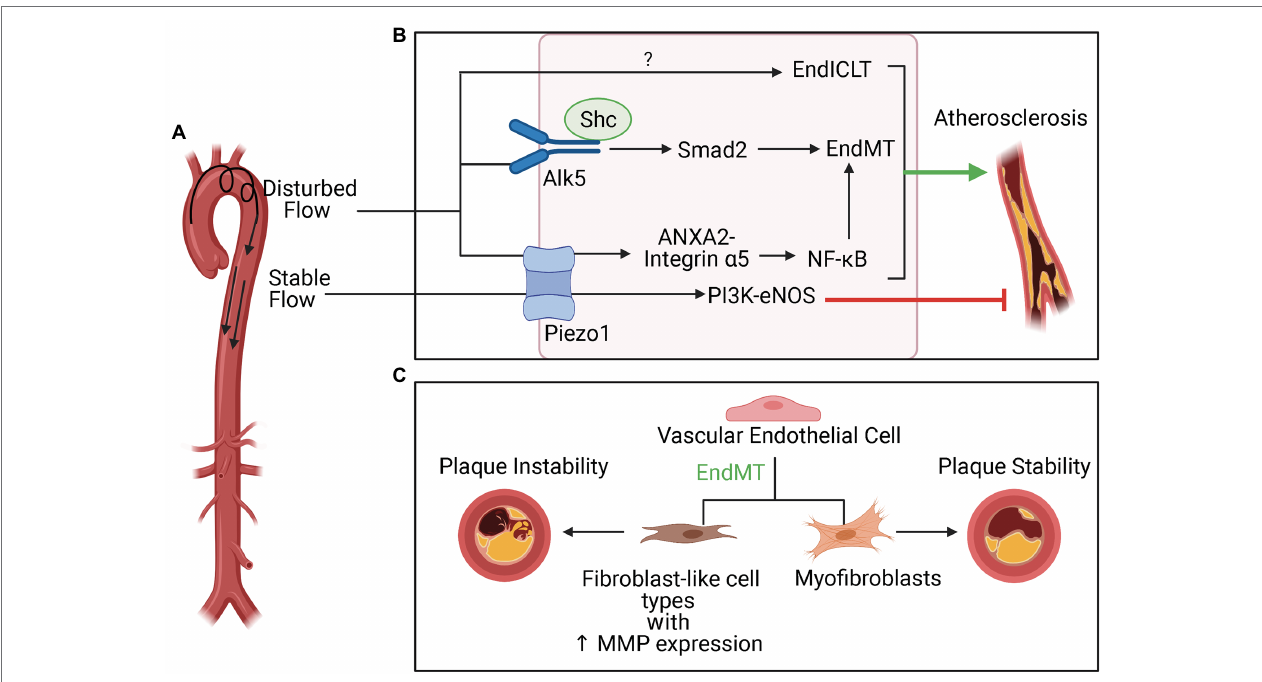
FIGURE 5 | Disturbed flow (d-flow), EndMT, and plaque stability in atherosclerosis. (A) d-flow that occurs at the lesser curvature of the aortic arch is atherogenic, whereas stable flow typically presents in the descending aorta is atheroprotective (EndICLT). (B) The mechanosensor Piezo1 is crucial to the differential responses to these hemodynamic profiles. In response to d-flow, Piezo1 activates the NF- κ B pathway, which is known to be important to inflammation-mediated EndMT. In addition to EndMT, d-flow also activates of endothelial-to-immune-cell-like transition. The mechanosensor Alk5 and associated protein Shc have been directly linked to activation of Smad-2 mediated EndMT pathways in response to d-flow in atherosclerosis. (C) EndMT can contribute to both plaque instability and plaque stability depending on whether EndMT results in transition of ECs to fibroblast-like cell types with increased matrix metalloproteinase expression or to